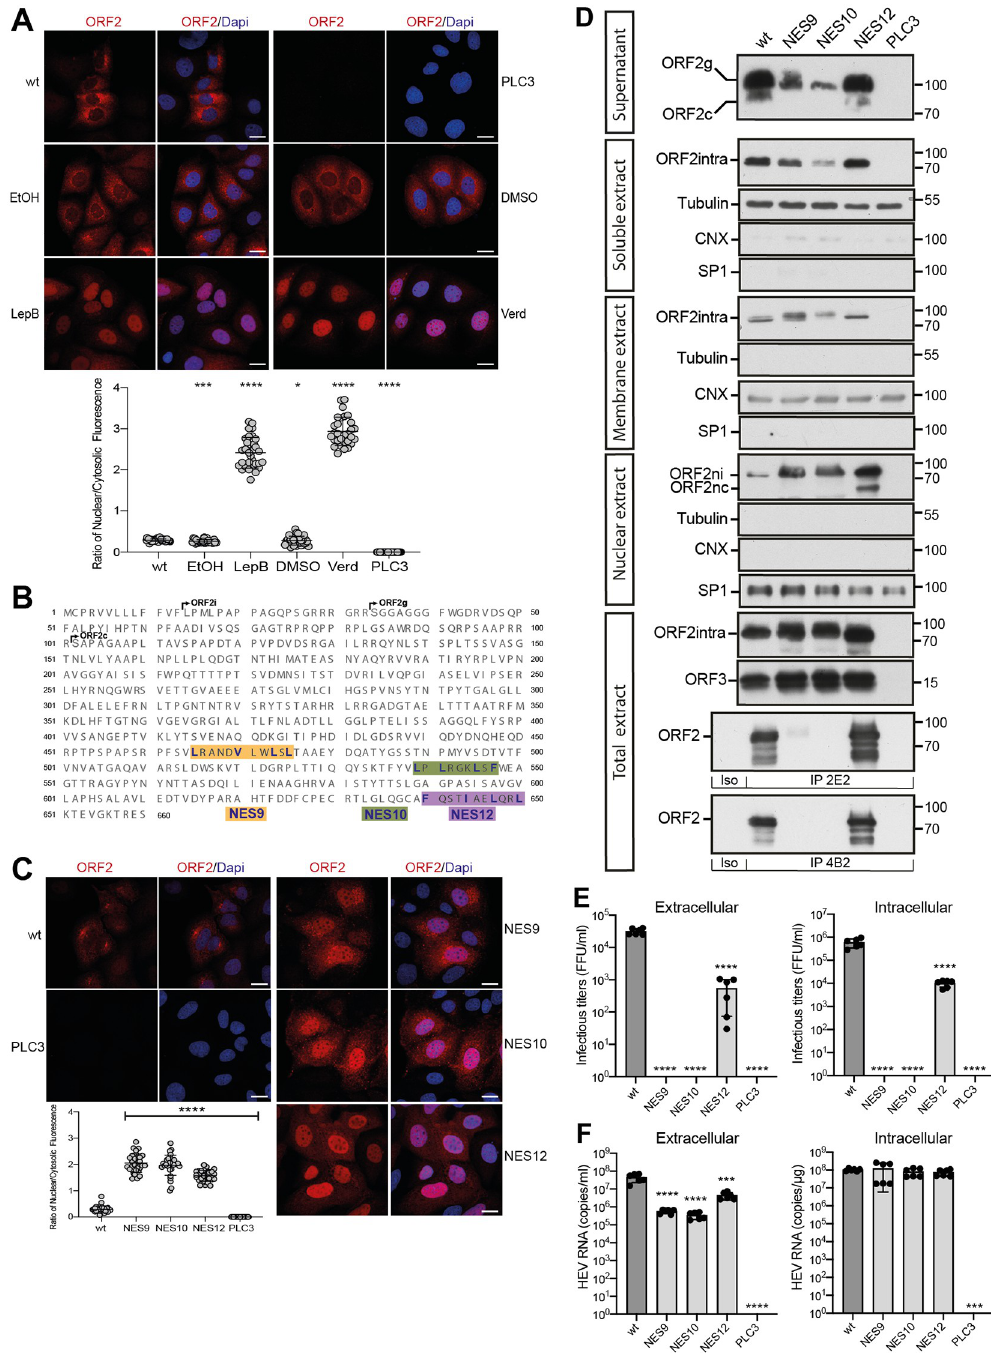
Fig 3. Nuclear export of the ORF2 protein. (A) Analysis of ORF2 nuclear export in inhibitors treated-PLC3/HEV-p6 cells. Cells were treated at 32 h.p.e with 20nM of Leptomycin B (LepB), 100nM of Verdinexor (Verd) or diluent (EtOH or DMSO, respectively) for 16h. Cells were processed for indirect immunofluorescence with the 1E6 anti-ORF2 Ab and analyzed by confocal microscopy (magnification x63). Red = ORF2; Blue = DAPI. (B) Schematic representation of HEV-p6 ORF2 protein sequence highlighting the three studied NES motifs (i.e., NES9, NES10 and NES12). (C) Subcellular localization of ORF2 NES mutants at 48 h.p.e. Red = ORF2; Blue = DAPI. In A and C, the scale bars correspond to 20 μ m, and nuclear/cytosolic fluorescence intensity quantification was done using ImageJ software (mean ± S.D., n � 30 cells, Kruskal-Wallis with Conover’s test). � p < 0.05, ��� p < 0.001, ���� p < 0.0001. (D) Subcellular fractionation of PLC3/HEV-p6 expressing ORF2wt and NES mutants at 4 d.p.e. Fractionation was done using a subcellular protein fractionation kit for cultured cells.